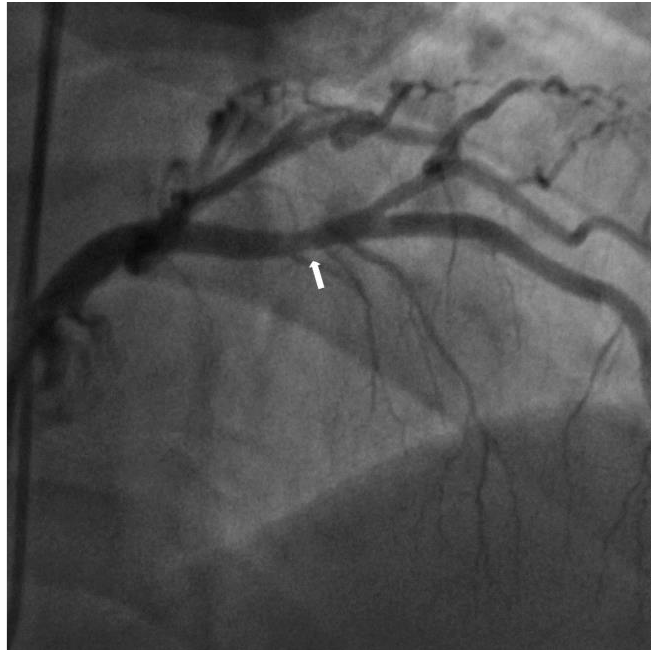
Figure 1. Mild stenosis (arrow) was noted in the mid-LAD artery in the RAO cranial view. RAO, right anterior oblique; CAG, coronary angiography; LAD, left anterior descending.